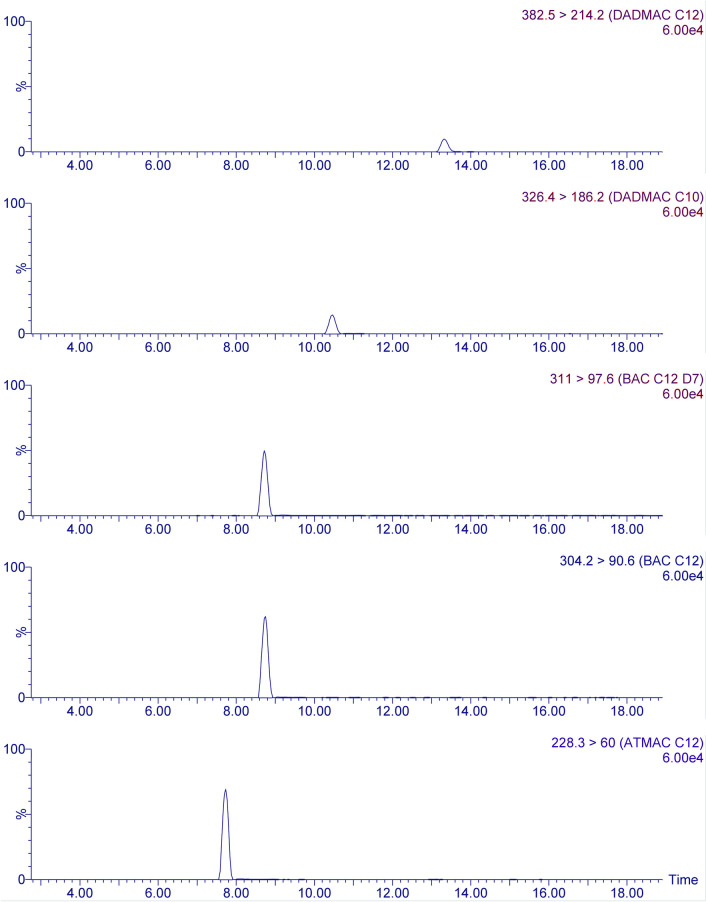
Chromatogram of DADMAC-C10, BAC-C12-D7, BAC-C12 and ATMAC-C12 in concentrations of 200 μg L-1 in AcN.